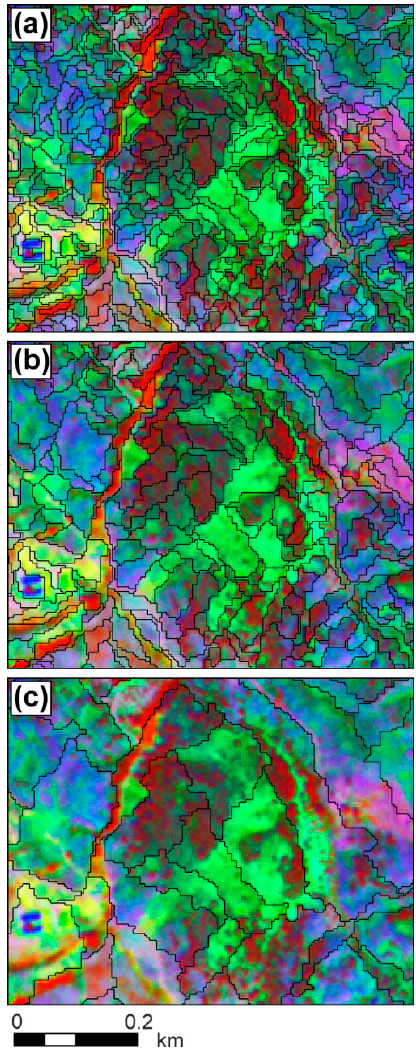
Figure 3. A subset of the segmentation results for scale parameter values of: ( a ) 1; ( b ) 2; and ( c ) 10. Black lines represent the borders of image objects. Background image is an RGB false-colour composite created using ATM MNF bands 1, 2, and 3, respectively (see Table 2).